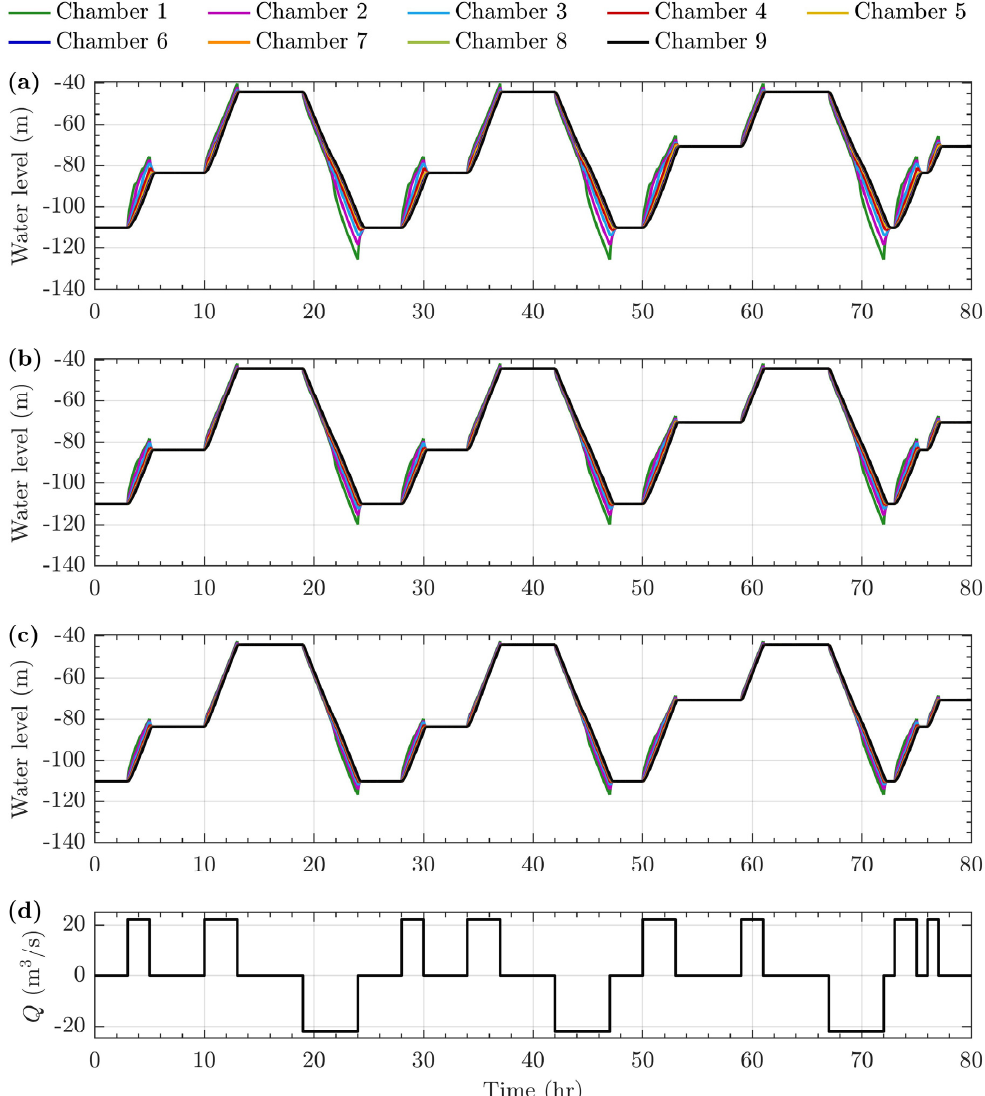
Figure 5. Evolution of the water level in the chambers of the underground reservoir of the UPSH for the winter discharge scenario, Q . The chambers are fully aerated and successive chambers are connected with two galleries with total cross sectional area of ( a ) 5 m 2 , ( b ) 6 m 2 , and ( c ) 7 m 2 . The corresponding portion of the winter discharge scenario is shown in ( d ). The roughness height in the connecting galleries is 5 cm while the water level is expressed with respect to the ground surface. Water was initially injected at hour 3 into chamber 1 (i.e., the deepest chamber) through the main 258 shaft and the water level gradually increased in all chambers, both for partially aerated (Figure 4) 259 and fully aerated (Figure 5) chambers. The initial increase of the water level until hour 5 occurred at 260 a different rate in each chamber, with the chambers closer to the main shaft exhibiting the steeper 261 gradients. This is attributed to the limited discharge capacity of the connecting galleries, which was 262 significantly lower than the incoming discharge of 22.2 m 3 /s from the main shaft. Notably, when the 263 water level in a chamber reached the second connecting gallery at 60 m above its bottom side, the 264 water level gradient became less steep as the water exchanges between adjacent chambers were 265 enhanced. As the cumulative cross-sectional area of the connecting galleries increased, the discharge 266 of water between adjacent chambers also increased and the water levels in the different chambers 267